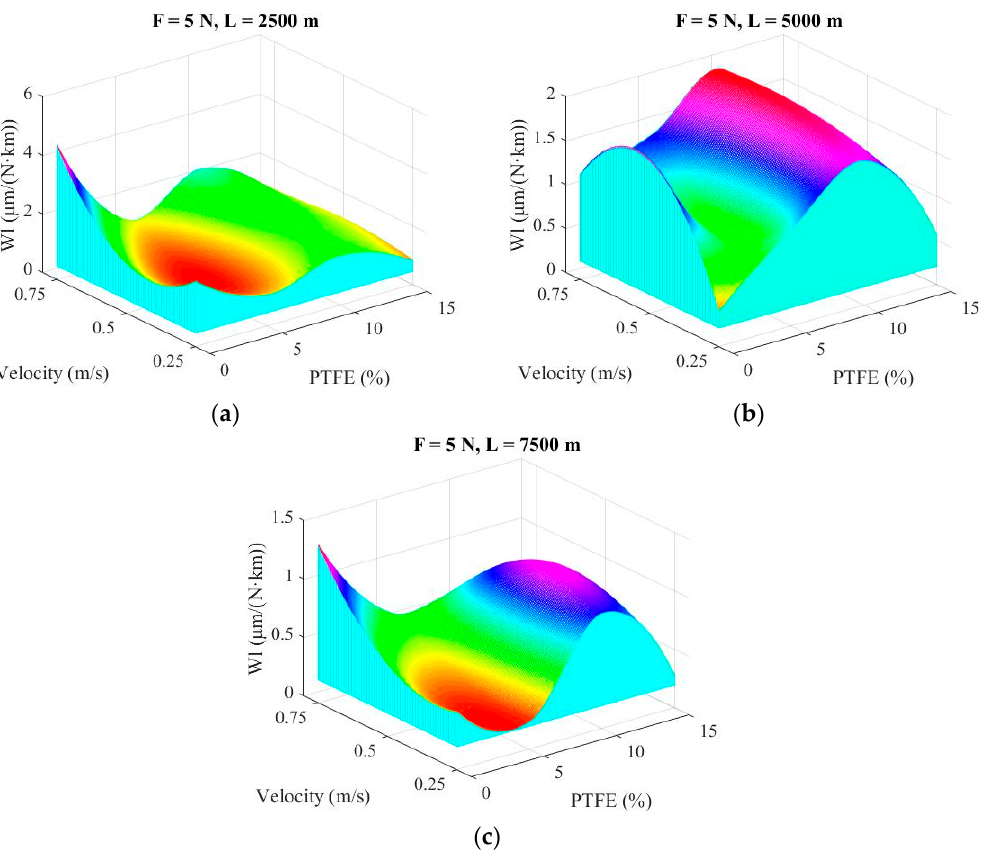
Figure 9. Maps of wear rate for tested load F = 5 N: ( a ) L = 2500 m; ( b ) L = 5000 m; ( c ) L = 7500 m.